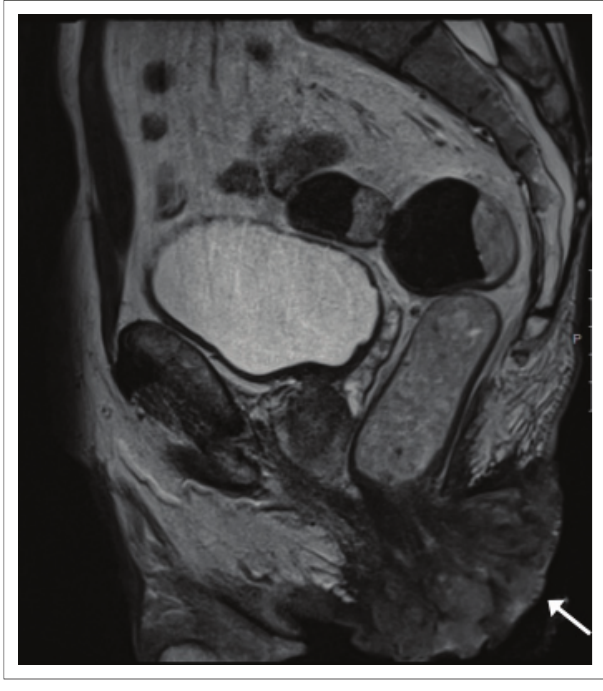
MR, magnetic resonance. FIGURE 6: Sagittal T2-weighted MR imaging of a 42-year-old male patient (as shown in Figure 5), demonstrating a large anal soft tissue mass (arrowed) of intermediate signal intensity, with local soft tissue